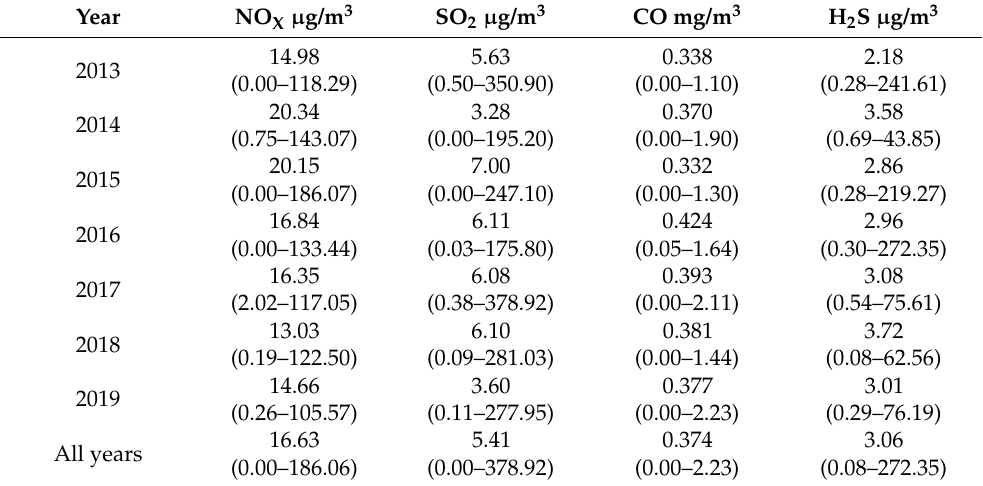
Table 1. Statistical summary of hourly concentrations of NO X , SO 2 , CO, H 2 S registered at the VZI monitoring station from January 2013 to December 2019. Mean concentration and, in rounded brackets, the min. and maximum